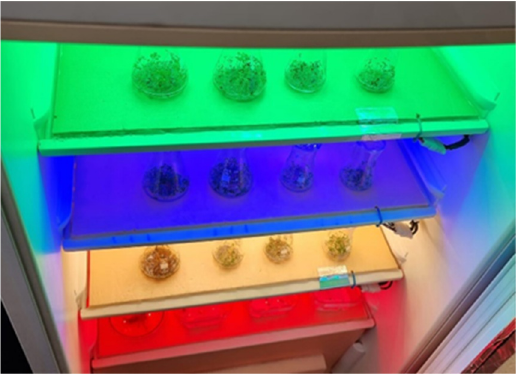
Figure 1. Aspects of LED experiment laboratory (Photo original Livadariu